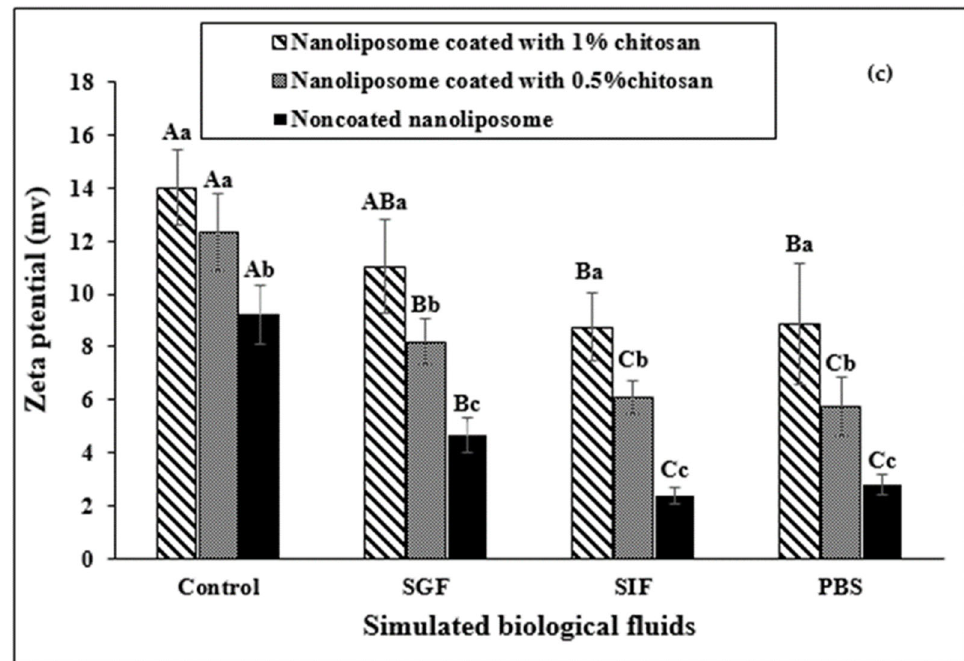
Figure 4. Size stability ( a ), PDI ( b ), and zeta potential ( c ) of nanoliposomes in simulated gastric fluid (SGF), intestine fluid (SIF), and PBS. Identical uppercase letters indicate no significant difference between one nanoliposome in different fluids compared to the control (initial measure) and identical lowercase letters indicate no significant difference between different nanoliposomes in one fluid.